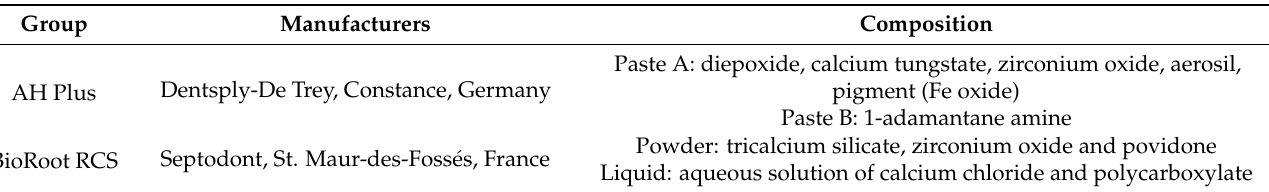
Table 1. Manufacturers and composition of the tested